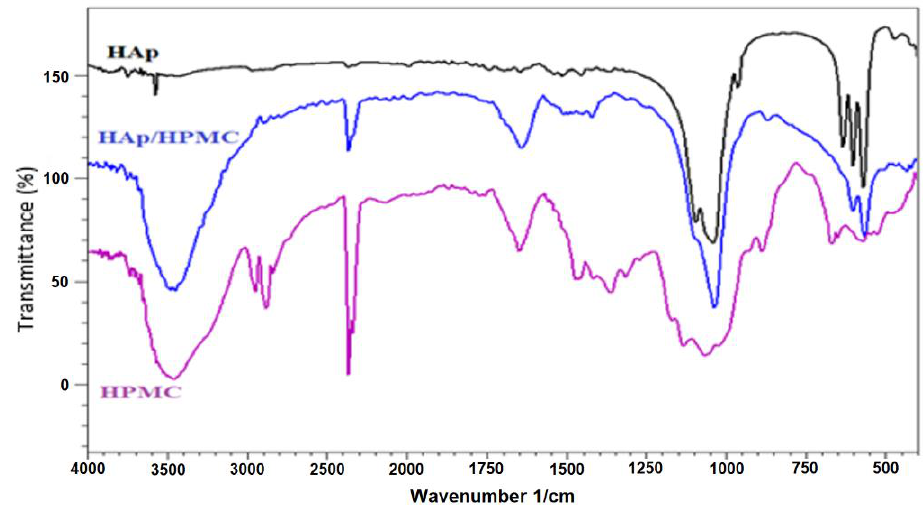
Figure 4. FT-IR spectra of HAp alone, HAp/HPMC and HPMC.